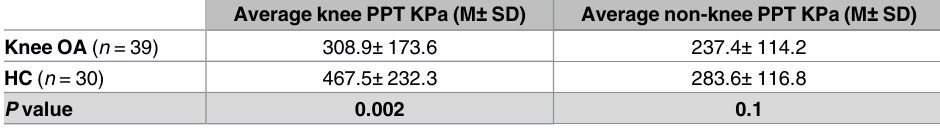
Table 3. Pressurepain threshold measurements for KOA vs.